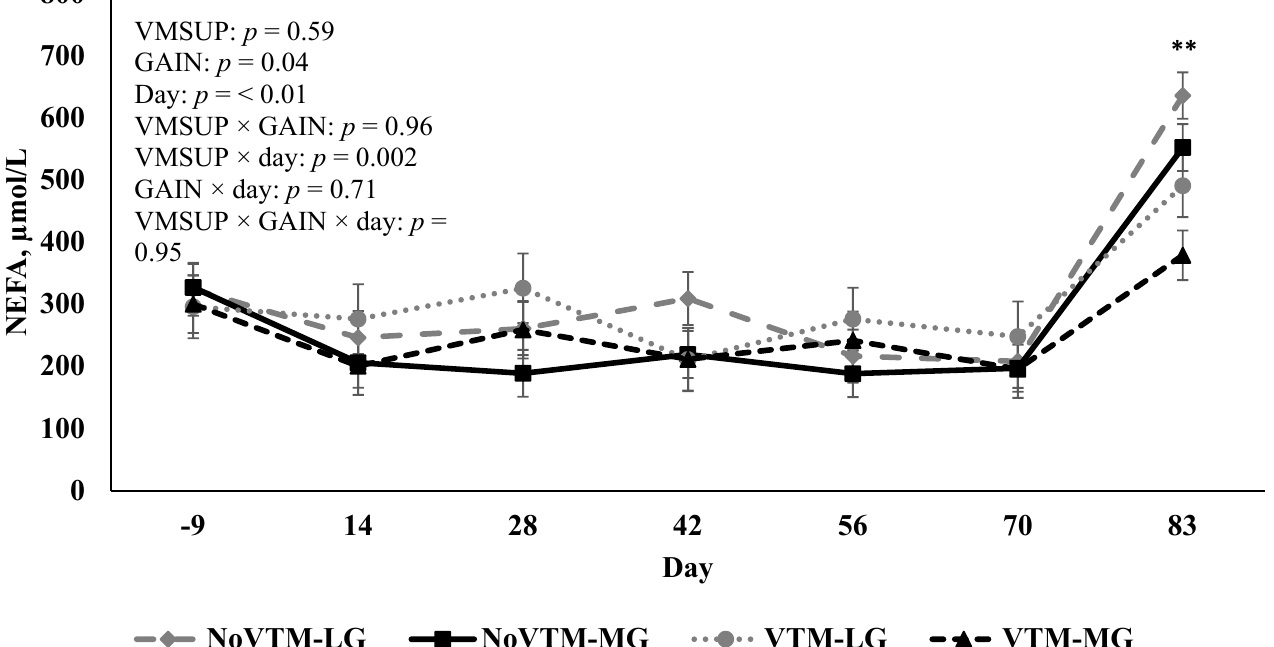
Figure 3. Effect of vitamin and mineral supplementation [VMSUP; supplemented (VTM) vs. unsupplemented (NoVTM); from pre-breeding to d 83 of gestation] and two different rates of gain [GAIN; low gain (LG), 0.28 kg/d, vs. moderate gain (MG), 0.79 kg/d; from breeding to d 83 of gestation] on blood non-esterified fatty acids (NEFA) concentrations. NoVTM-LG ( n = 9): No vitamin and mineral supplement, low gain; NoVTM-MG ( n = 9): No vitamin and mineral supplement, moderate gain; VTM-LG ( n = 9): Vitamin and mineral supplement, low gain; VTM-MG ( n = 8): Vitamin and mineral supplement, moderate gain. A VMSUP × Day interaction ( p = 0.002) was observed for NEFA, being similar for NoVTM and VTM from d − 9 to 70; and greater ( p = 0.02) for VTM than NoVTM on day 83 as indicated by **. Values are least squares means, with error bars depicting standard error. Fetal BW was not affected by main effects of VMSUP or GAIN ( p ≥ 0.27) or their interaction ( p = 0.28; Table 7). However, fetal intestinal weight was affected by a VMSUP × GAIN interaction ( p = 0.03), where intestine from VTM-MG fetuses were heavier than those from VTM-LG ( p = 0.04), with all other treatments being similar ( p ≥ 0.08). This